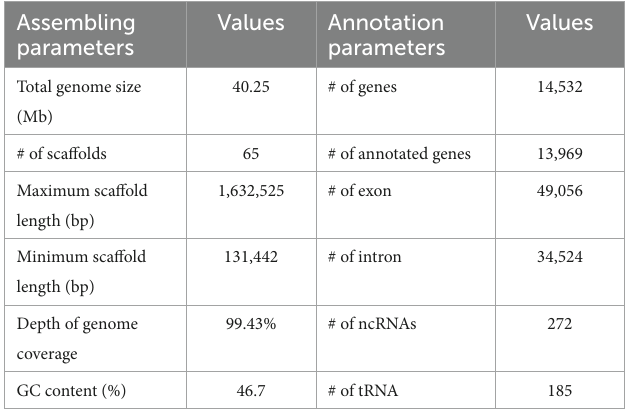
TABLE 1 Genome features of Penicillium herquei . Assembling